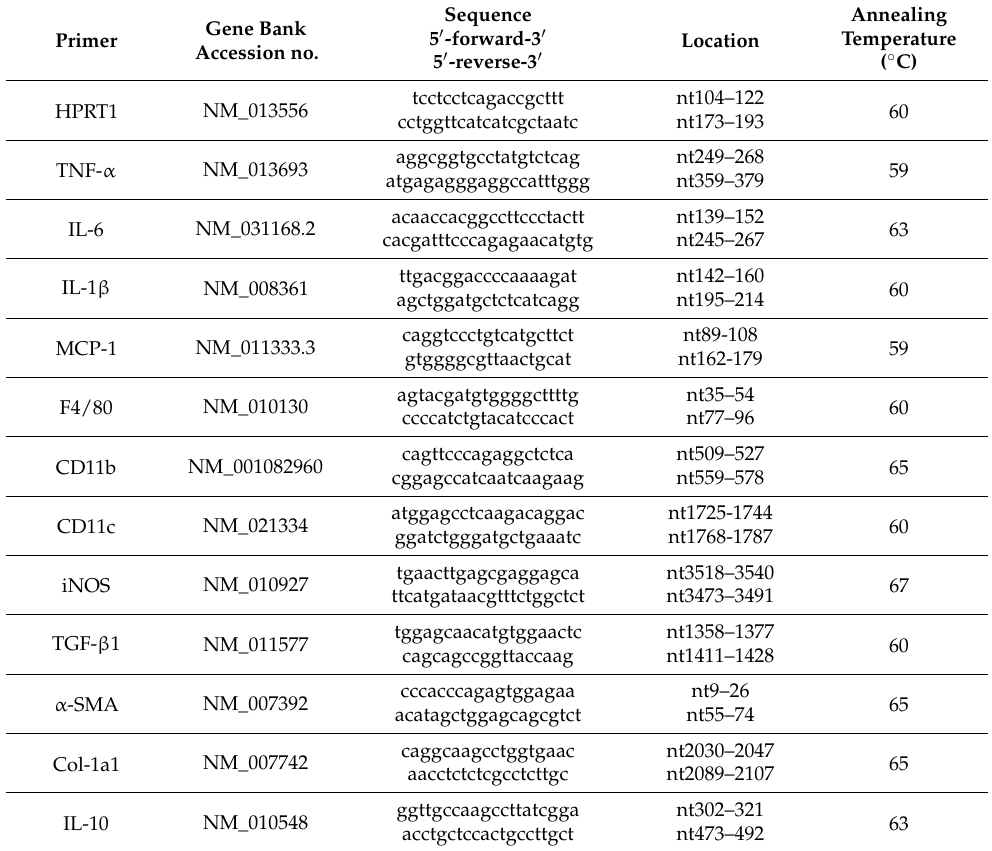
Table 1. Oligonucleotide sequences and annealing temperature for quantitative real-time PCR. Sequence Annealing Gene Bank 5 (cid:48) -forward-3 (cid:48) Temperature Primer Location Accession no. 5 (cid:48) -reverse-3 (cid:48) ( ◦